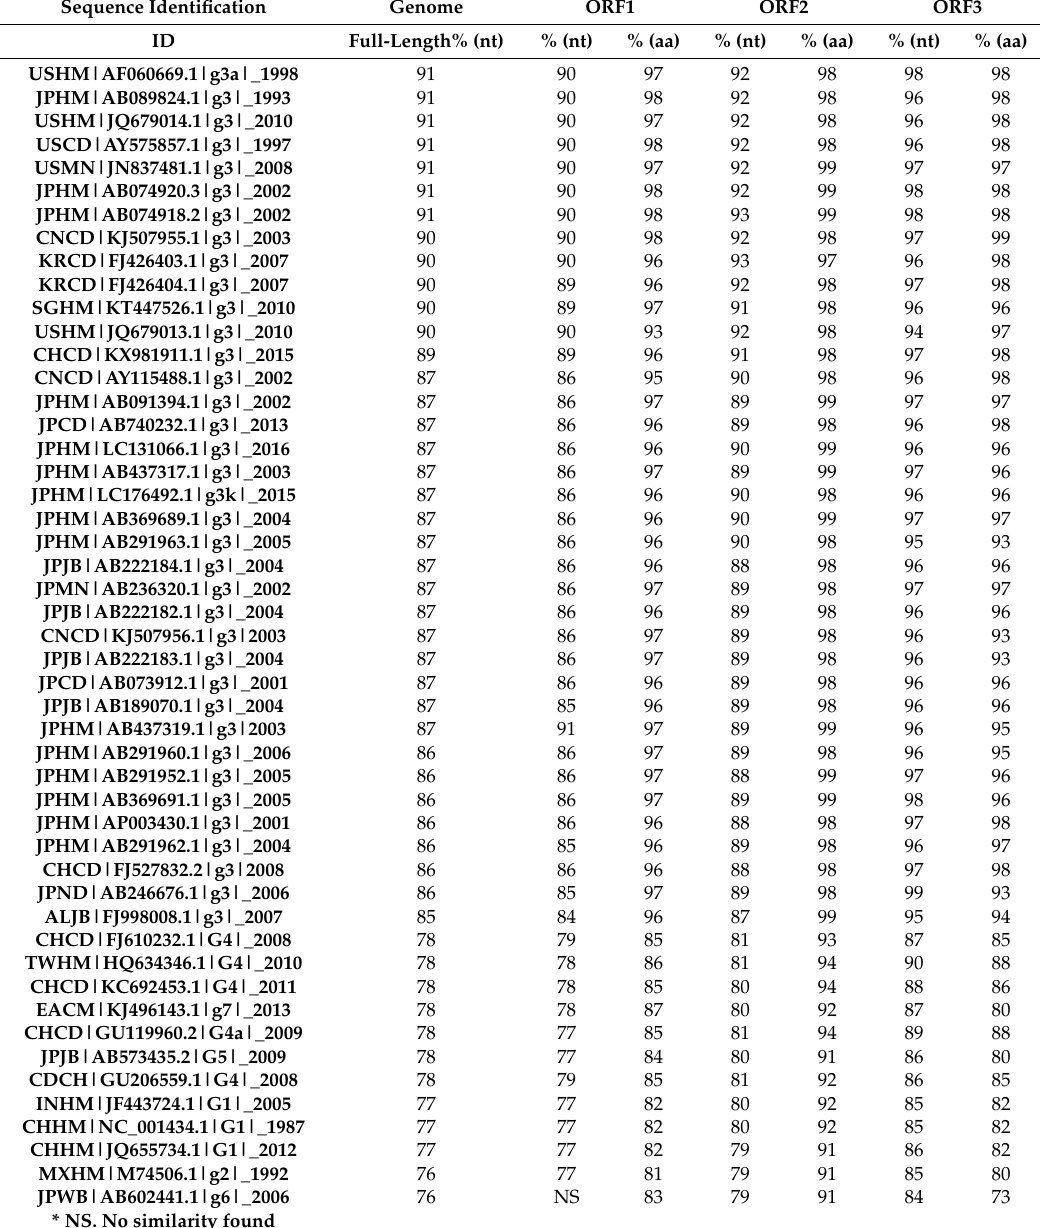
Table 2. Nucleotide and amino acid identity (%) of swine HEV isolate MXCDg3_B1c|_2016 with complete genome sequences of various genotypes retrieved from GenBank with over 75%